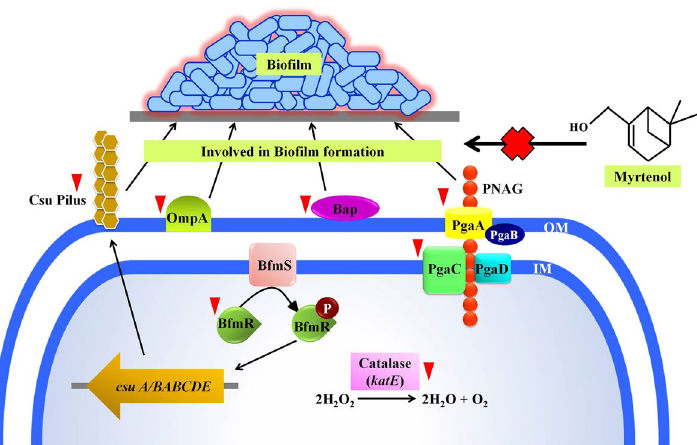
Figure 10. A schematic diagram representing the effect of myrtenol on biofilm associated genes expression in AB. Red coloured inverted triangles indicate down regulation of genes by